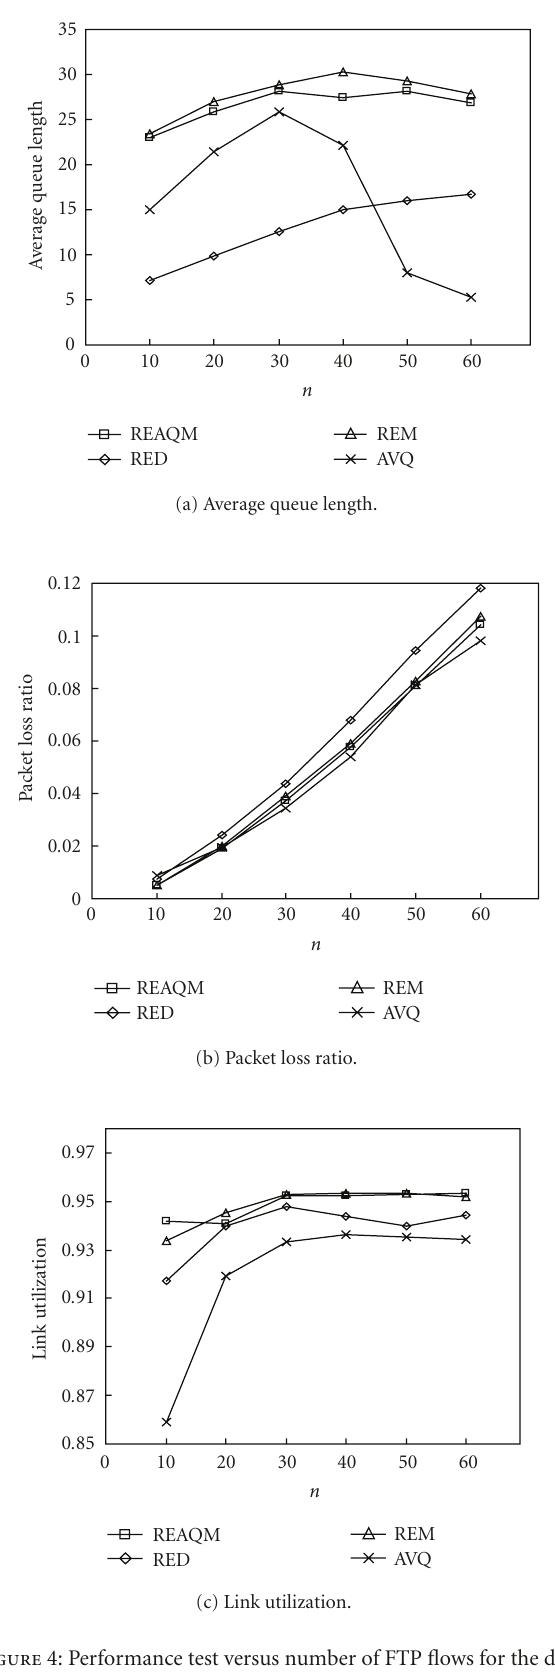
Figure 4: Performance test versus number of FTP flows for the dif- ferent AQM schemes over wireless